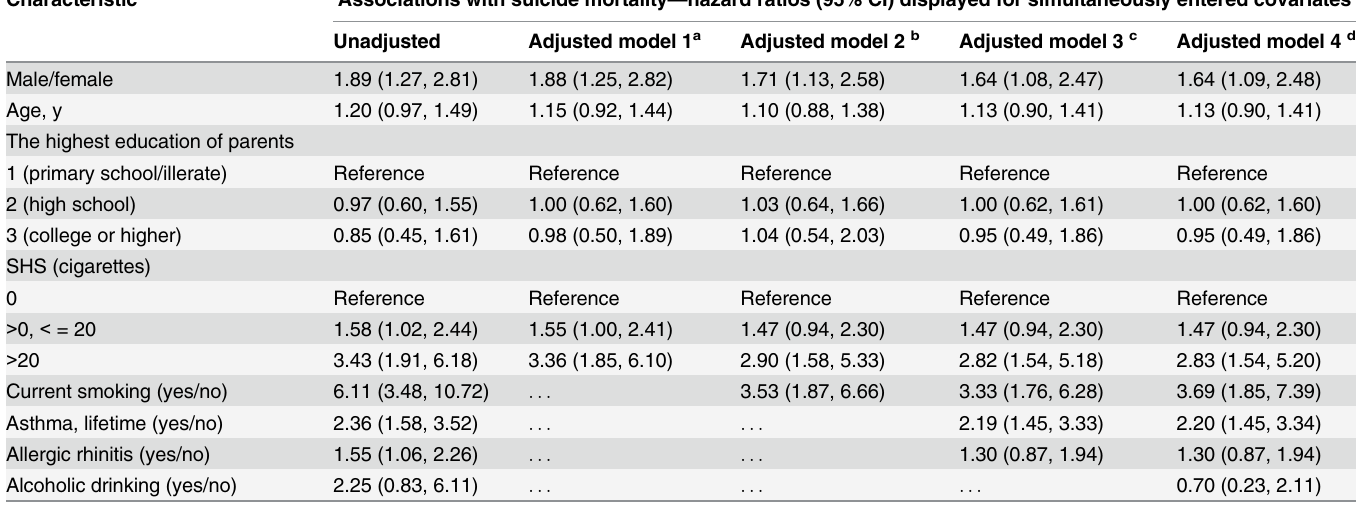
Table 4. Cox proportional hazards regression analyses of factors associated with suicide mortality. Associations with suicide mortality — hazard ratios (95% CI) displayed for simultaneously entered